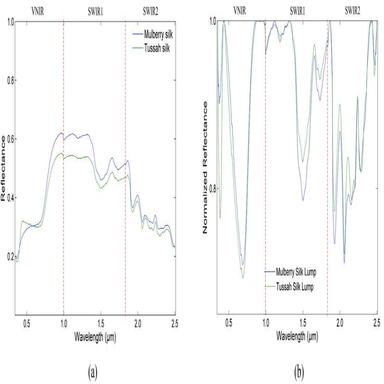
Spectral comparison between textile samples of silk, (a: reflectance spectra; b: CR spectra).